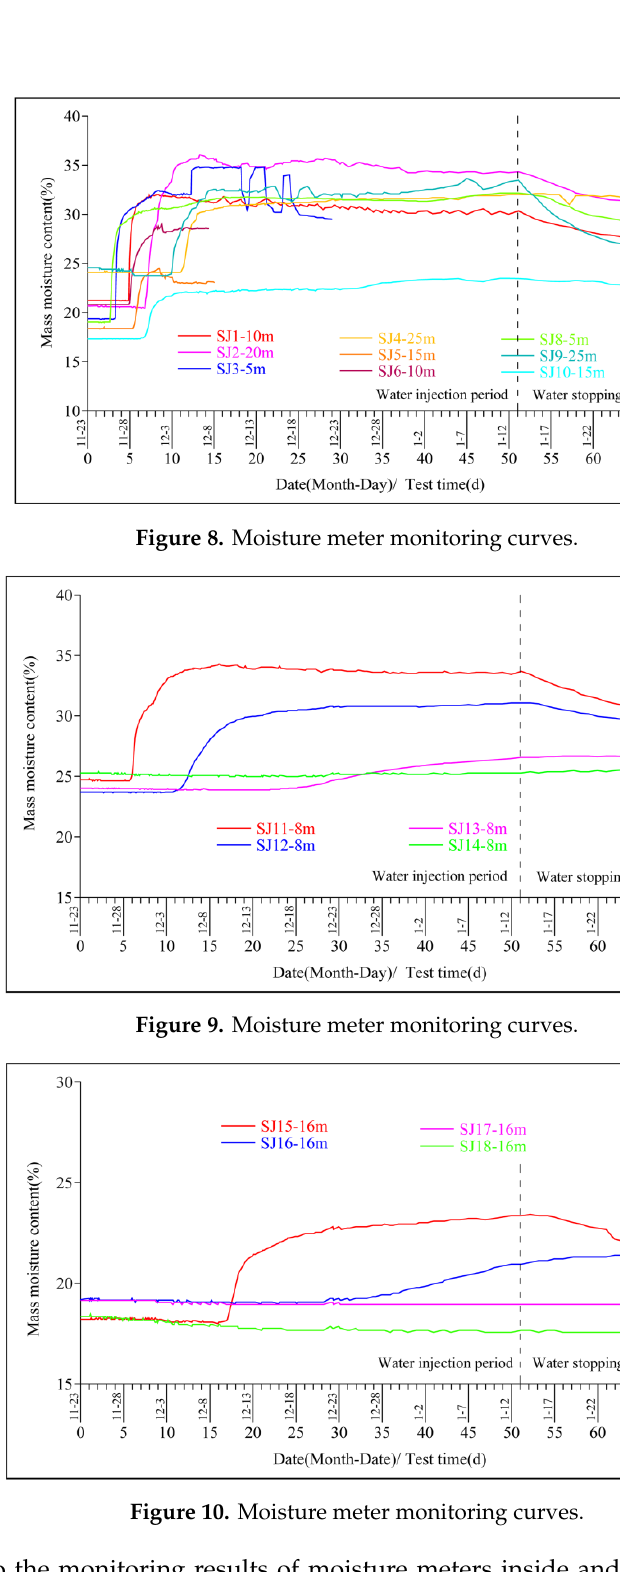
Figure 7. Water injection rate of the test. Figure 8 is the moisture meter monitoring curve. The readings of moisture meters SJ3 and SJ8 with the depth of 5 m started to change from the 4th to the 5th day; the readings of moisture meters SJ4 and SJ9 with the depth of 25 m started to change from the 15th; SJ3, SJ5, and SJ6 were damaged after using for a period of time, so only part of the data were drawn; SJ7 was damaged after the start of water immersion, and its data were not drawn. Among them, SJ5 and SJ10 with a depth of 15 m were in the paleosol horizon, when the moisture meter values of the two were in a stable state, the measured mass water content was about 23%, which was significantly smaller than the moisture value of other groups. The mass moisture content measured by SJ20 with a buried depth of 20 m was at the highest value, it was higher than that of SJ4 and SJ9, both of which had a depth of 25 m, indicating that the loess was denser along the depth direction. SJ1–SJ10 moisture meters were buried